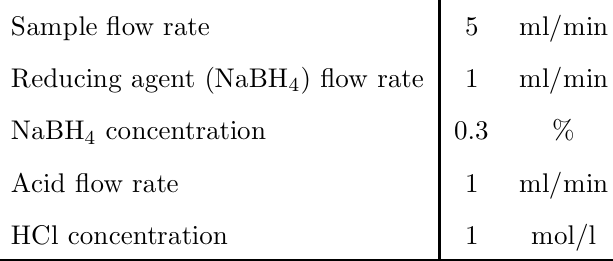
Table 1 Parameters of the analytical system used for hydride